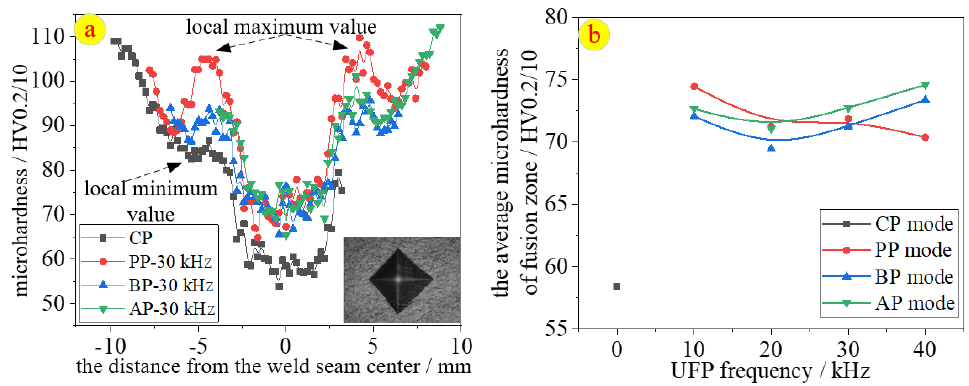
Figure 8. The welds microhardness ( a ) and its average value of fusion zone ( b ).